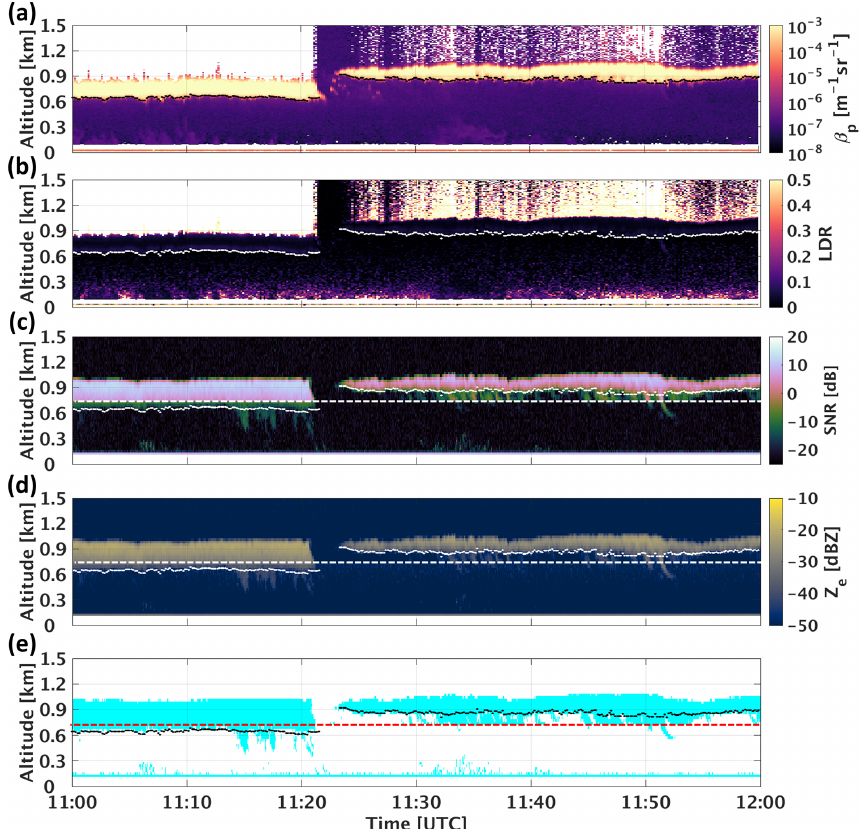
Figure C1. Hour containing a non-precipitating supercooled layer between 11:00 and 11:15UTC on 1 September 2015 over the NSA. (a) High spectral resolution lidar (HSRL; Eloranta, 2005) particulate backscatter cross section, (b) HSRL linear depolarization ratio, (c) KAZR signal-to-noise ratio (SNR), (d) KAZR Z e , and (e) KAZR cloud mask using an SNR threshold of − 16dB (see Silber et al., 2018a). Dashed horizontal white and red lines designate the height below (above) which the KAZR GE (MD) mode is used. Black or white dots designate the HSRL liquid cloud base height data product (see Silber et al., 2018c, for the algorithm description; Silber et al., 2018b, 2019c, for the data product). See Appendix C for